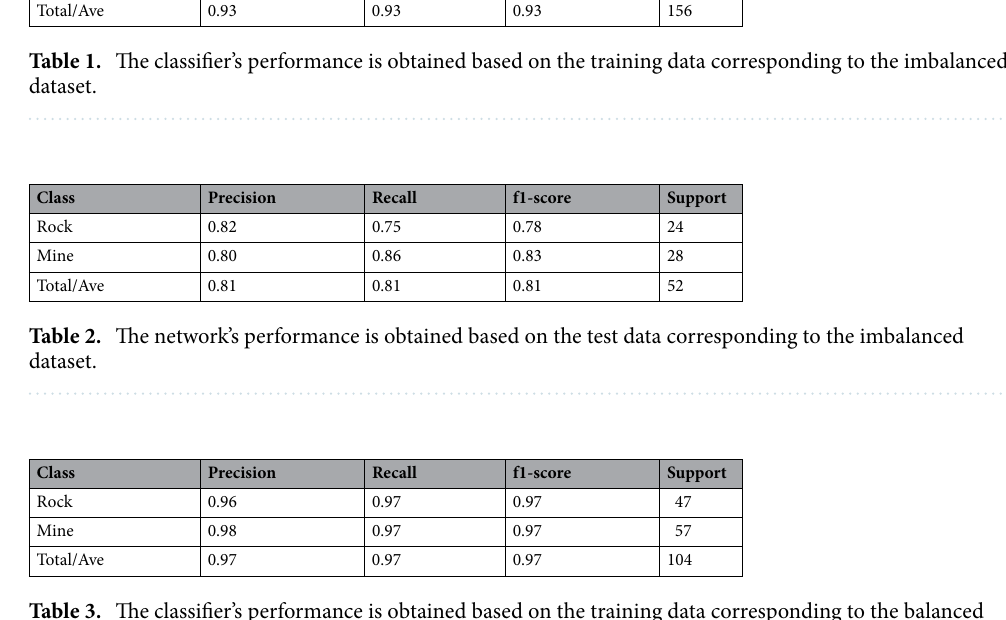
Table 3. The classifier’s performance is obtained based on the training data corresponding to the balanced dataset.